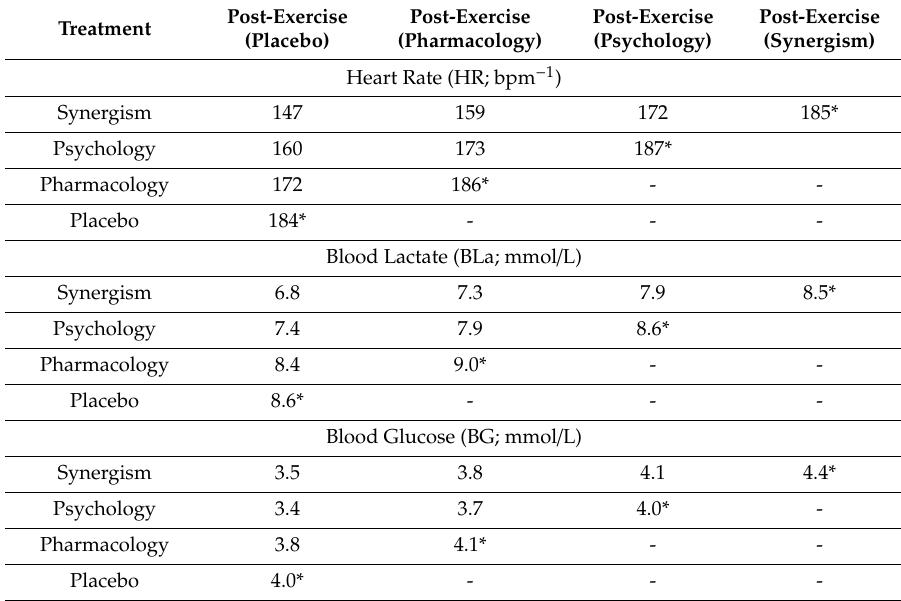
Table 2. Post-exercise heart rate (HR), BLa and BG divided by T LIM per min (exercise termination across treatments advocated by *).